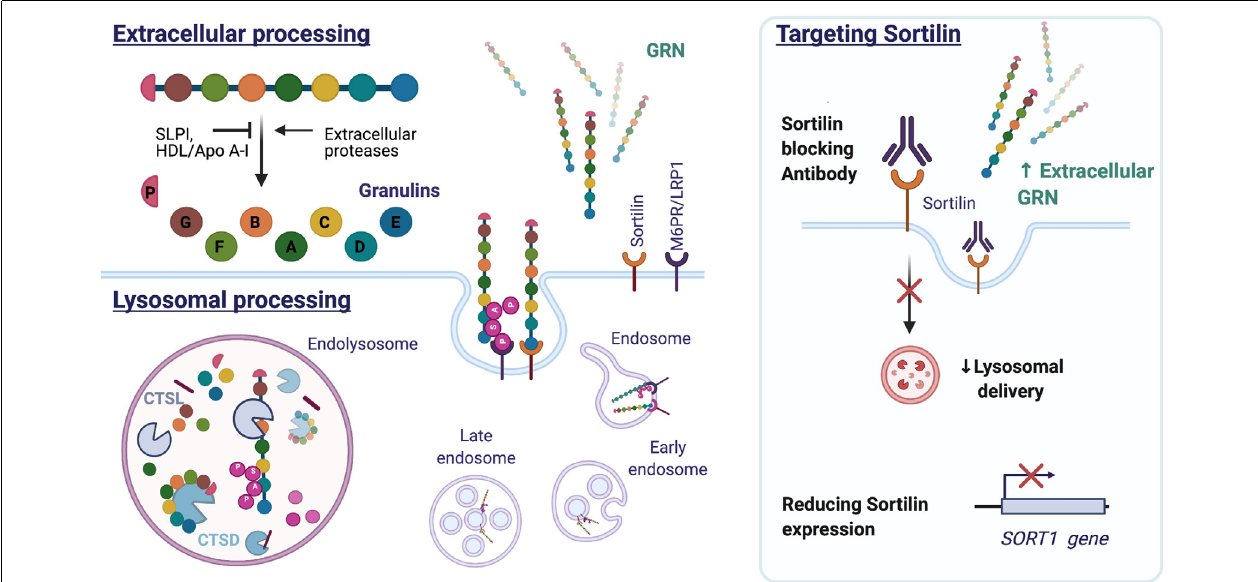
FIGURE 6 | Structure and processing of mammalian GRN. GRN consists of seven and a half granulin domains. The linker sequences can be cleaved by extracellular and intracellular proteases, releasing individual granulins or a combination of GRN modules. Both SLPI and HDL/Apo A-I can bind GRN and inhibit GRN processing. Extracellular GRN is rapidly endocytosed and targeted to the lysosome directly by binding sortilin or indirectly by forming a heterodimer with prosaposin, which utilizes the M6PR or LRP1 receptors. In the lysosome, GRN is cleaved into granulins by Cathepsin L (CTSL) and possibly other hydrolases. GRN contributes to lysosomal homeostasis by increasing the stability of lysosomal enzymes [e.g., Cathepsin D (CTSD) and consequently affects the processing of prosaposin (PSAP)]. Reducing sortilin ( SORT1 ) gene expression or preventing GRN-sortilin interaction with blocking antibodies can increase extracellular GRN levels and prevent lysosomal degradation of GRN (HDL: high-density lipoprotein, Apo A-I: apolipoprotein A-I, M6PR: mannose 6-phosphate receptor, LRP1: lipoprotein receptor-related protein